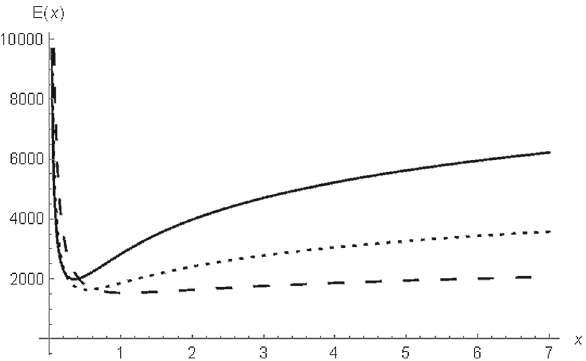
Fig. 2 The plots of E ( x ) (in MeV) for three sets of values: (a) p = q = 3, l 2 = l 3 = 1 fm (dashed line), (b) p = q = 3, l 2 = l 3 = 2 fm (dotted line) and (c) p = q = 3, l 2 = l 3 = 3 fm (continuous line). The minimum of the energy corresponds to l 1 = 0 . 227 fm, l 1 = 0 . 323 fm and l 1 = 0 . 42 fm respectively